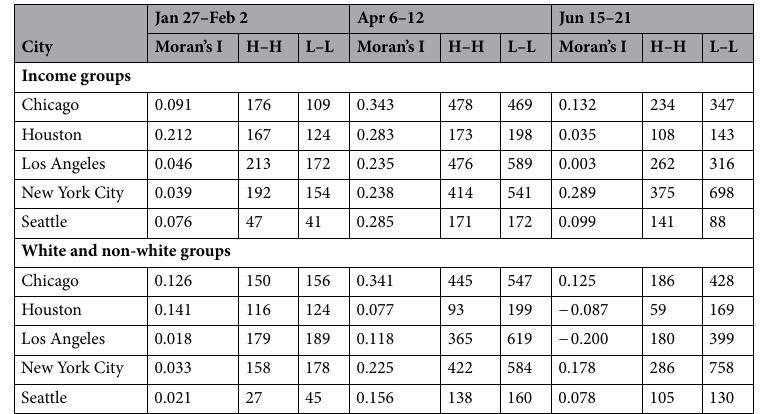
Table 2. Bivariate Moran’s I statistic for POI-CBG network for income groups. The Bivariate Moran’s I statistic was calculated for the five urban locations for the median income groups and the percentage of white and non-white groups. Jan 27–Feb 2 represents a time period before the stay-at-home policy; Apr 6–12 represents a time period after stay-at-home policy and Jun 15–21 represents a time period following weeks after the stay- at-home policy. H–H represents the number of high–high clusters and L–L represents the number of low–low clusters; both of the number of observed clusters were statistically significant of at least p-values < 0.05.